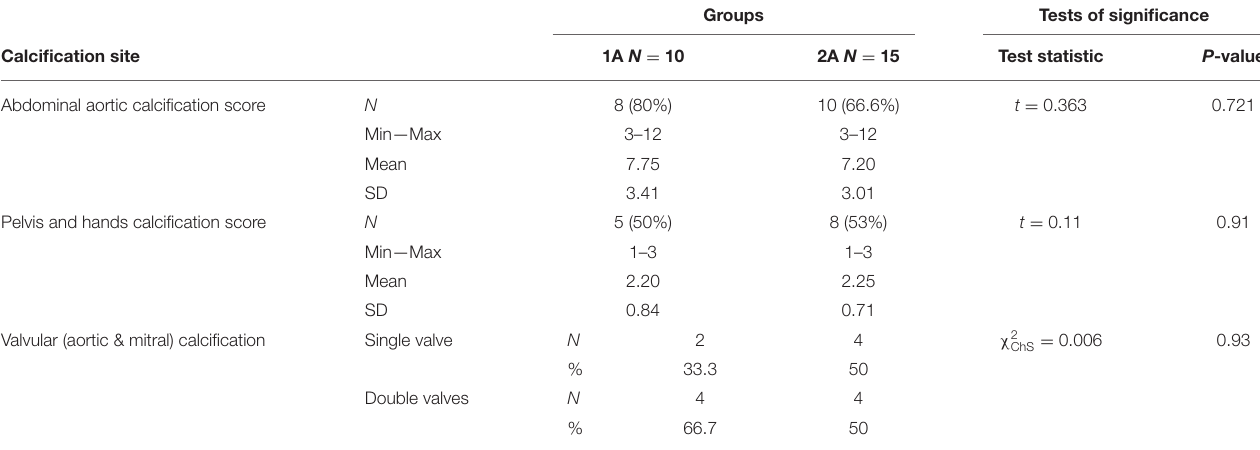
TABLE 3 | Comparison of the cardiovascular calcifications sites and scores between group 1A and 2A.